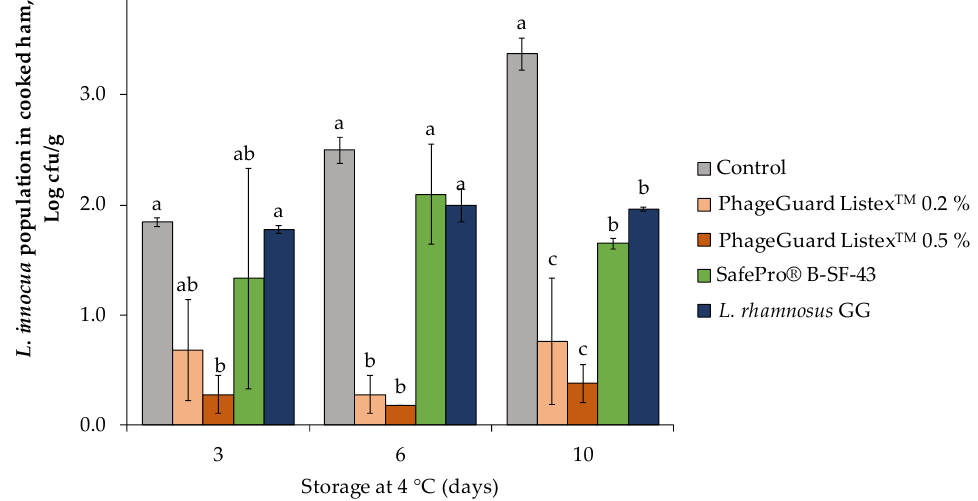
Figure 1. Effect of the biopreservative treatments in L. innocua population on cooked ham plugs throughout storage at 4 °C. Values are means ± standard deviations of three biological replicates. Bars marked with different letters (a, b and c) represent statistically significant differences among treatments ( p < 0.05) at each sampling time.